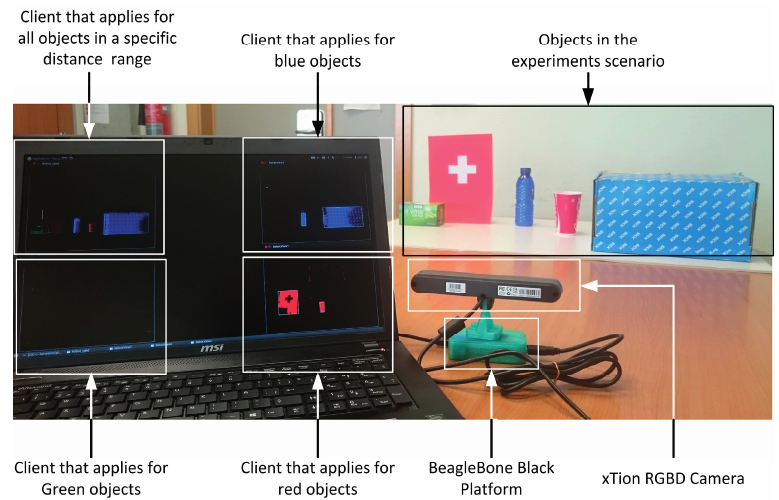
Figure 8. RGBD smart resource based on XTion and BeagleBoard working.